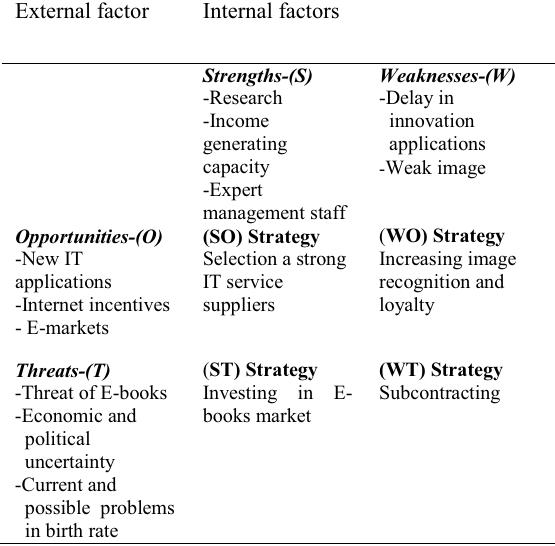
Table 2. SWOT analysis matrix for HTP External